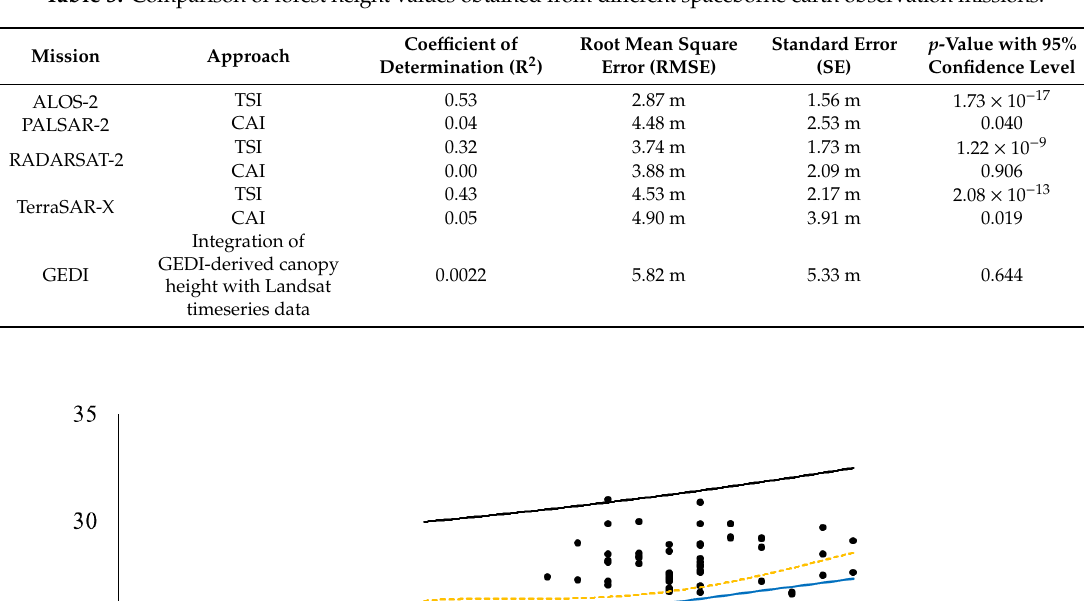
Table 3. Comparison of forest height values obtained from different spaceborne earth observation missions.